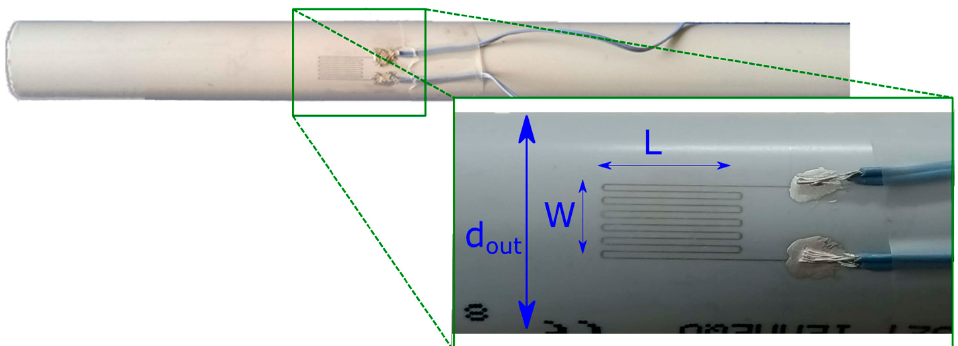
Figure 5. Strain gauge printed on a PVC conduit of 20 mm external diameter (d out ). The active gauge length (L) is 10 mm and the gauge width (W) is 5.5 mm. Two wires connect each pad to the measurement system.